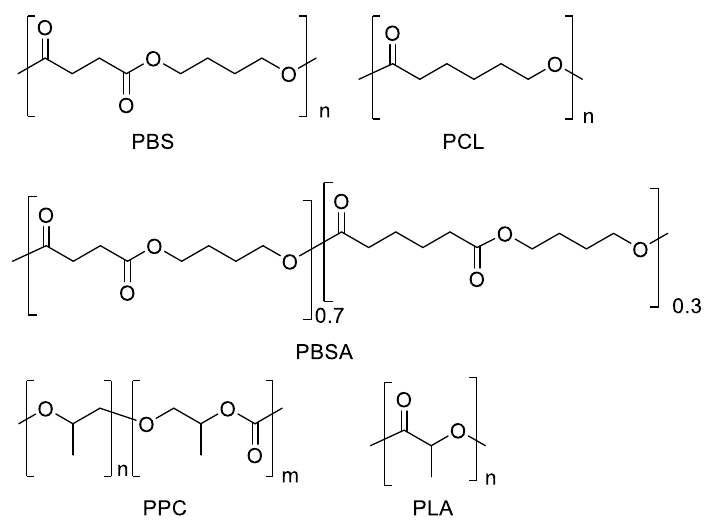
Figure 1. Chemical structures of PBS, PCL, PBSA, PPC and PLA.